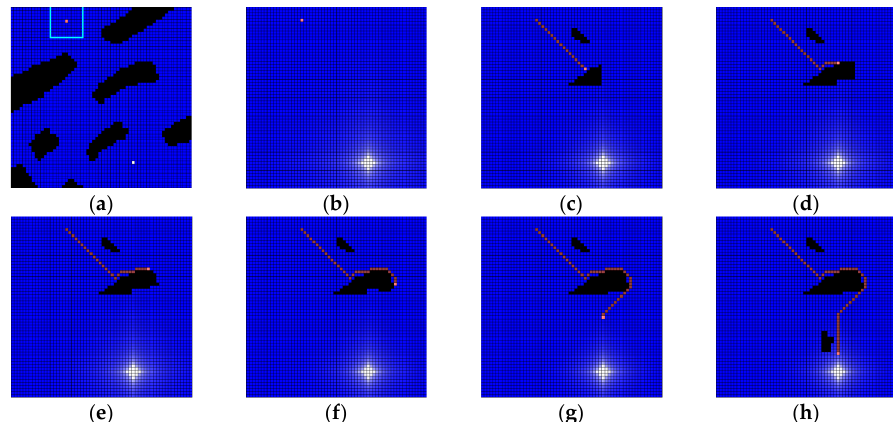
more complex than Figure 15 and the same as Figure 12a. The sensing area of the robot is assumed as 11 × 11 cells around the robot (see Figure 16a). The water drainage occurred once at the first time (see Figure 16b) and the robot moves to the plughole without recognition of any obstacle at first. occurred again, from the plughole, not to the whole area, but to the current robot position (see Figure 16c–f). Figure 16g,h shows that the robot could finally reach the plughole in the dynamic environment. Here, the water drainage totally occurred five times and the path length is 62.